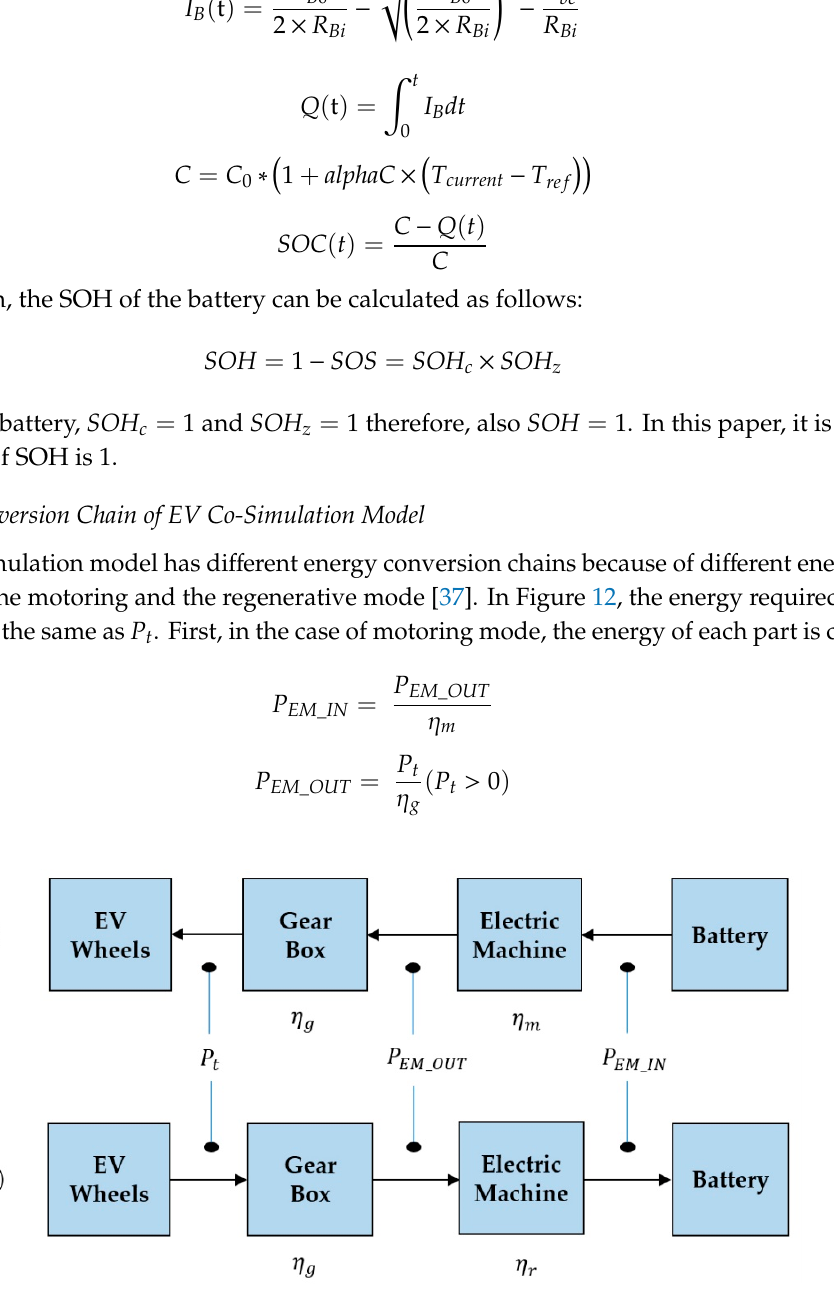
Figure 13. Simulation model including sensor information. 5. Simulation Experiments and Analysis We experimentally validated the EV simulation model with the proposed algorithms to verify the results by employing driving cycle data. In the test, the new European driving cycle (NEDC), where 𝑉 (cid:3040)(cid:3028)(cid:3051) equals 120 km/h and 𝑉 (cid:3028)(cid:3049)(cid:3034) equals 32 km/h, was adopted as a standard driving cycle. The NEDC, one of the standard driving cycles that includes specifications of urban, rural, and highway driving conditions, is composed of four consecutive ECE-15 urban driving cycles (UDC) and one extra-urban driving cycle (EUDC). Although the NEDC was originally designed to assess gasoline- driven vehicles, it is now used to evaluate and measure the power consumption and driving range of diesel-driven, hybrid and electric vehicles. The NEDC reflects the necessary conditions for evaluating the EV system as it provides average velocity, certain ratio of braking time, and acceleration similar to those in actual driving. Therefore, it provides cases that closely resemble real- world situations in EV model simulations. We used FMU SDK [44] and OpenDDS [45] for implementing F-DCS. For these experiments, we used six personal computers and an Ethernet switch. Table 1 shows the EV simulation parameter setting values.